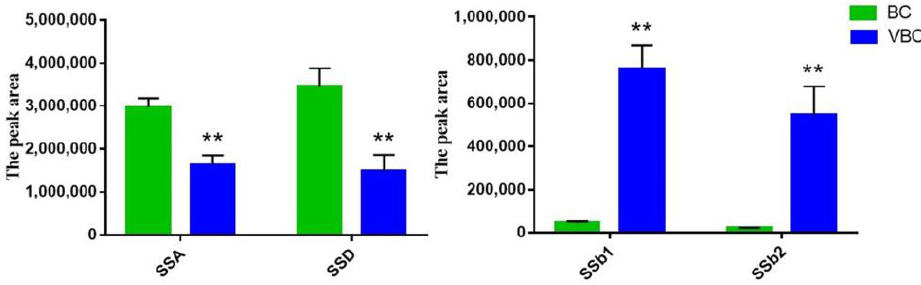
Figure 3. The peak area statistics of SSA, SSb1, SSb2, and SSD from the BC and VBC groups ( n = 6, means ± SDs). Analyzed using a one-way ANOVA. ** p < 0.01: BC group vs. VBC group.